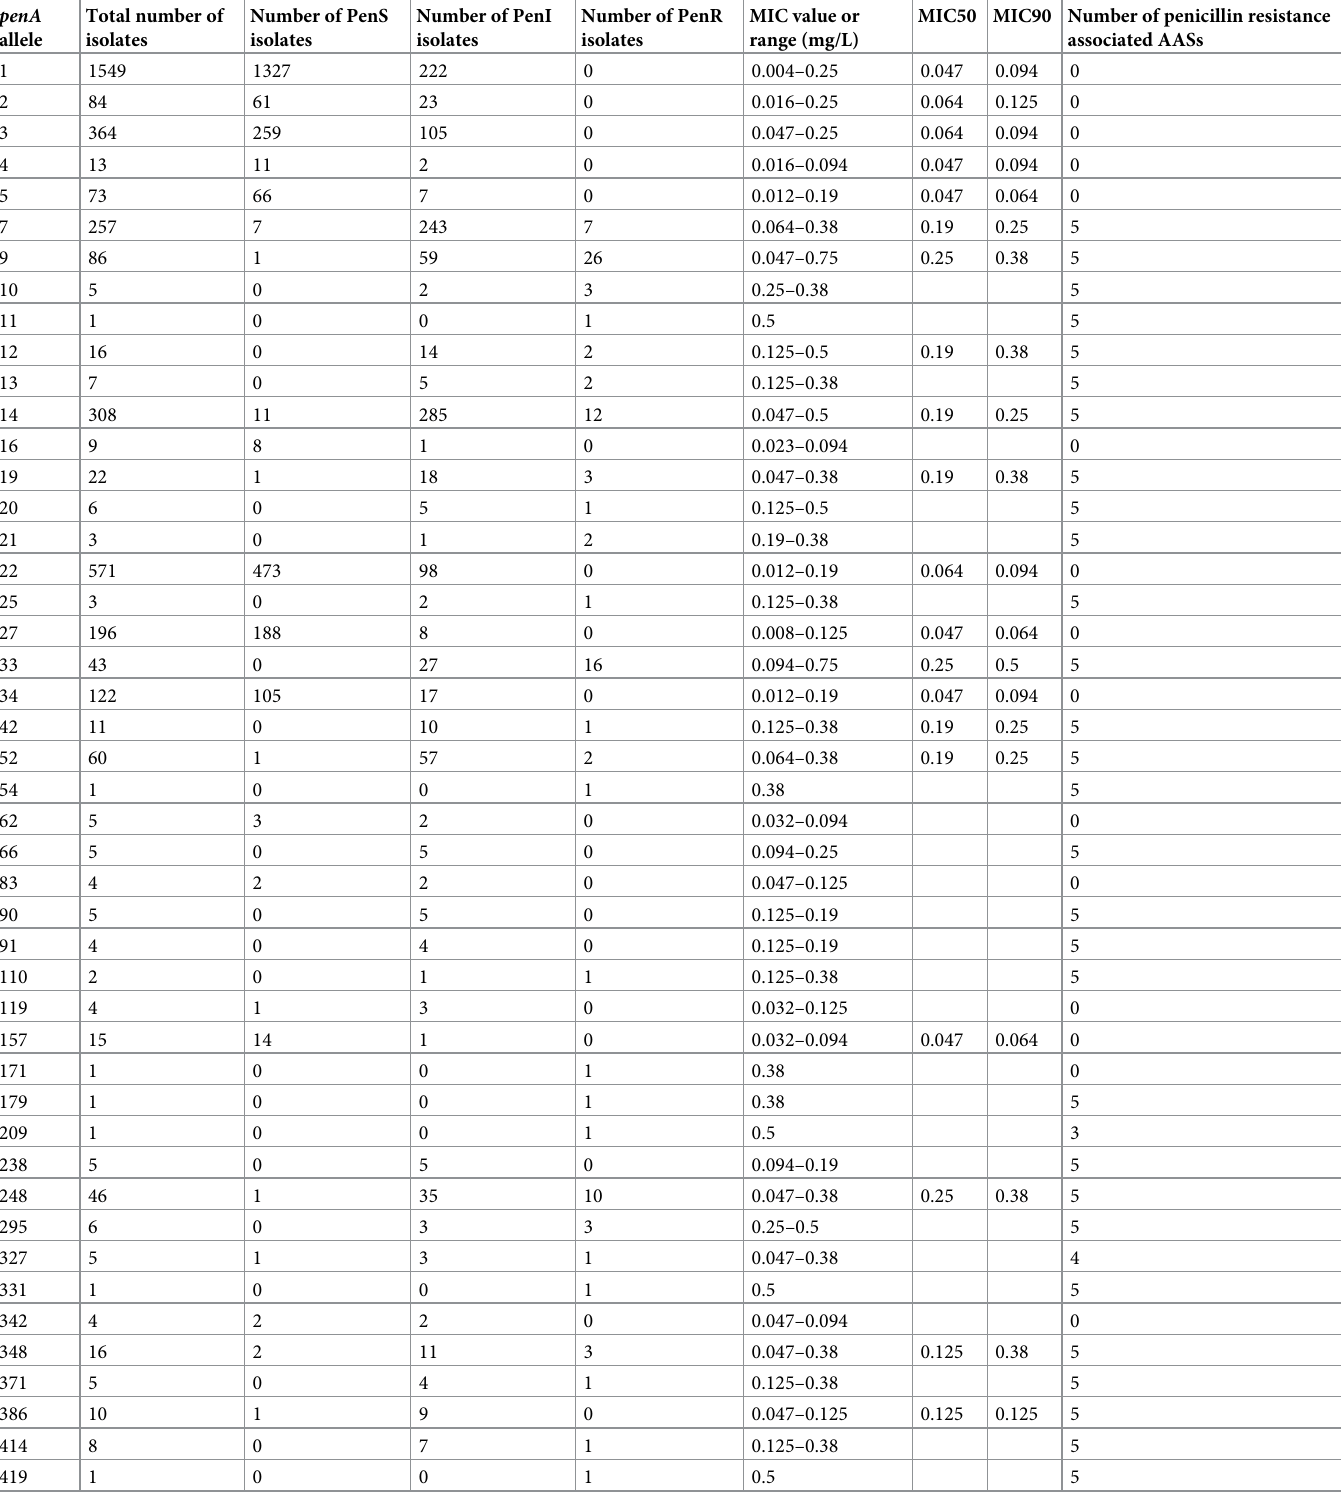
Table 2. PenA alleles among PenR and PenI IMD isolates in England, Wales and Northern Ireland from 2010/11 to